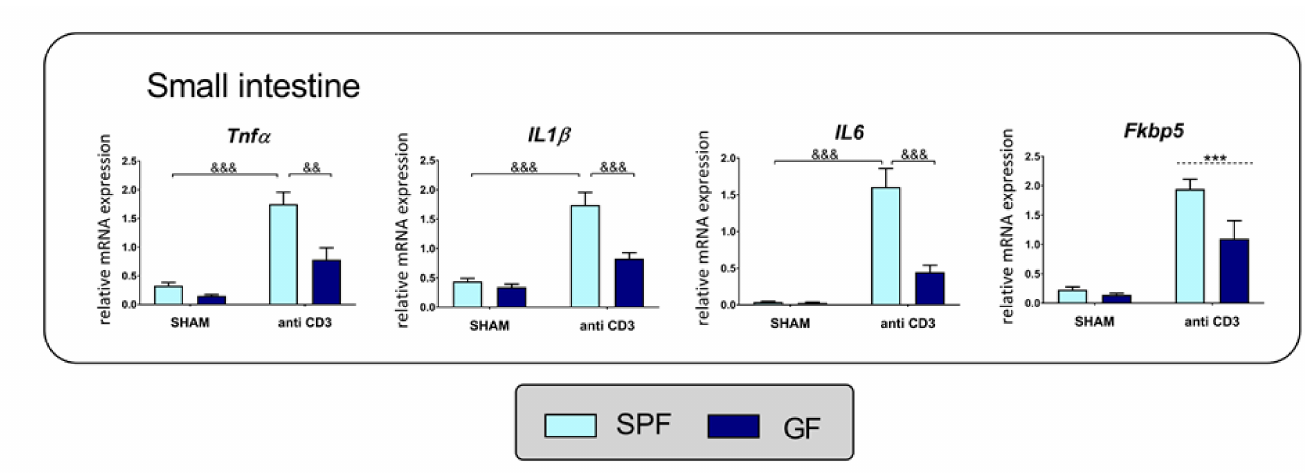
Figure 5. Anti-CD3 antibody treatment and microbiota alter the expression of cytokine and glucocorticoid-responsive genes. Gene expression of tumor necrosis factor α ( Tnf α ), interleukin 1 β ( IL1 β ), interleukin 6 ( IL6 ) and cochaperone FK506 binding protein 5 ( Fkbp5 ) was measured by quantitative PCR in the small intestine of specific pathogen-free (SPF) and germ-free (GF) mice 4 h after in vivo treatment with the anti-CD3 antibody or saline (SHAM). The data are expressed as means ± SEM. The ampersand sign indicates a significant difference ( && p < 0.01, &&& p < 0.001) of microbiota*stress interaction effect. Where no interaction was observed, a main effect of stress has been marked by placing a dashed horizontal line with an asterisk (*** p < 0.001) above the bars for the stress-exposed groups.